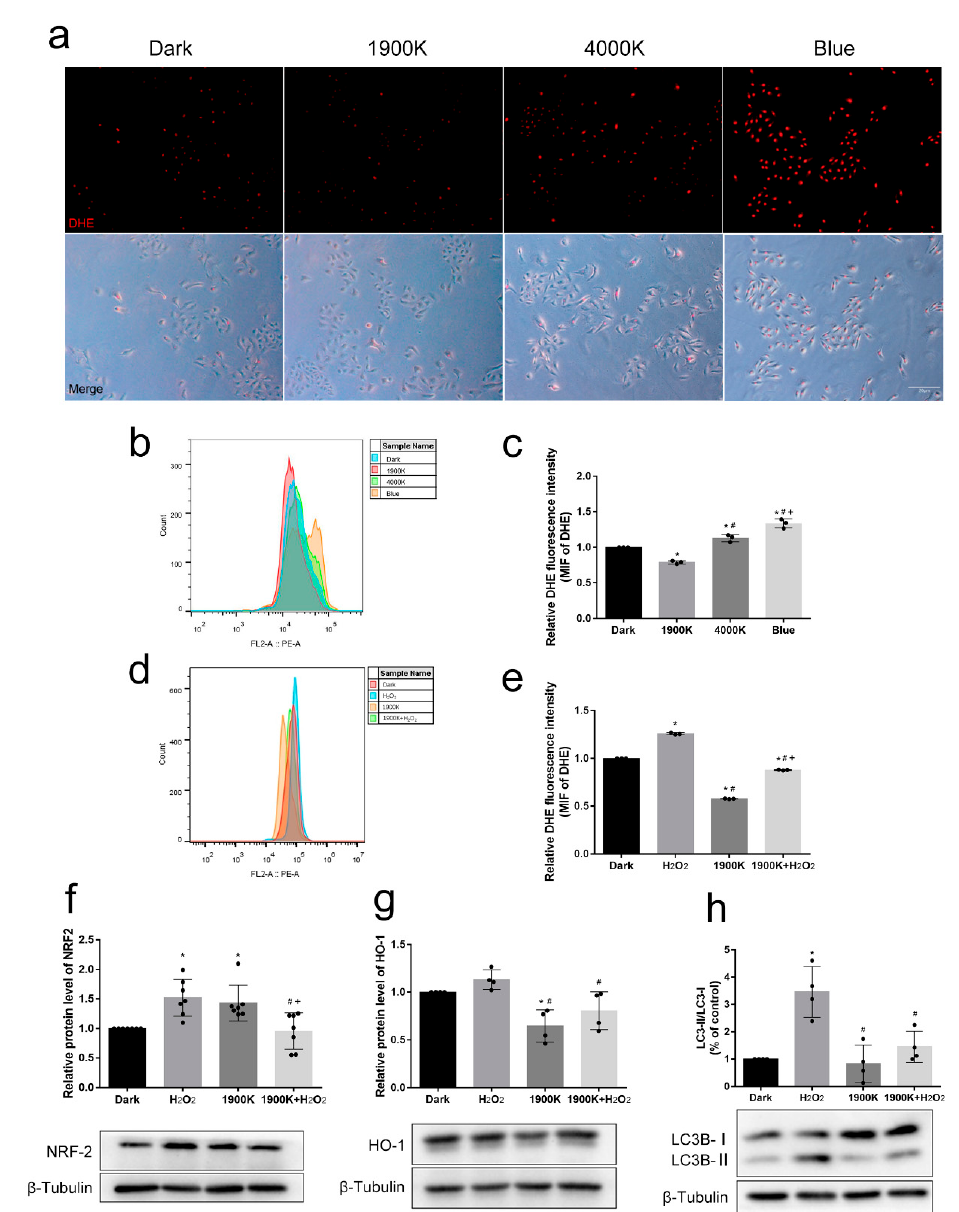
Figure 3. The 1900 K LEDs play an active role in the antioxidative stress of ARPE-19 cells. ( a ) The fluorescence of dihydroethidium (DHE) after irradiation with 1900 K, 4000 K, and blue-light LEDs for 48 h. The number and intensity of fluorescence represent the level of intracellular reactive oxygen species (ROS). The top panel shows the red fluorescence of DHE, and the lower panel consists of merged images with the bright field; n = 3. ( b , c ) Quantitative fluorescence analysis of dark, 1900 K, 4000 K, and blue-light LED groups; n = 3. * Significantly different from dark group (one-way ANOVA: 1900 K, p = 0.0013; 4000 K, p = 0.0237; blue, p < 0.0001); # significantly different from 1900 K (one- way ANOVA, p < 0.0001); + significantly different from 4000 K (one-way ANOVA, p = 0.0016). ( d , e ) Quantitative fluorescence analysis of dark, H 2 O 2 , 1900 K, and 1900 K + H 2 O 2 groups of light pretreatments involving 1900 K LED pre-illumination for 48 h and then 400 µ M H 2 O 2 damage for 6 h; n = 3. * Significantly different from dark group (one-way ANOVA, p < 0.0001); # significantly different from H 2 O 2 group (one-way ANOVA, p < 0.0001); + significantly different from 1900 K group (one-way ANOVA, p <0.0001). ( f – h ) The levels of nuclear factor E2-related factor 2 (NRF2) ( n = 7), heme oxygenase-1 (HO-1) ( n = 4), and microtubule-associated protein 1 light chain 3 beta (LC3B) ( n = 4) were detected by Western blot analysis in four groups of light pretreatments. β